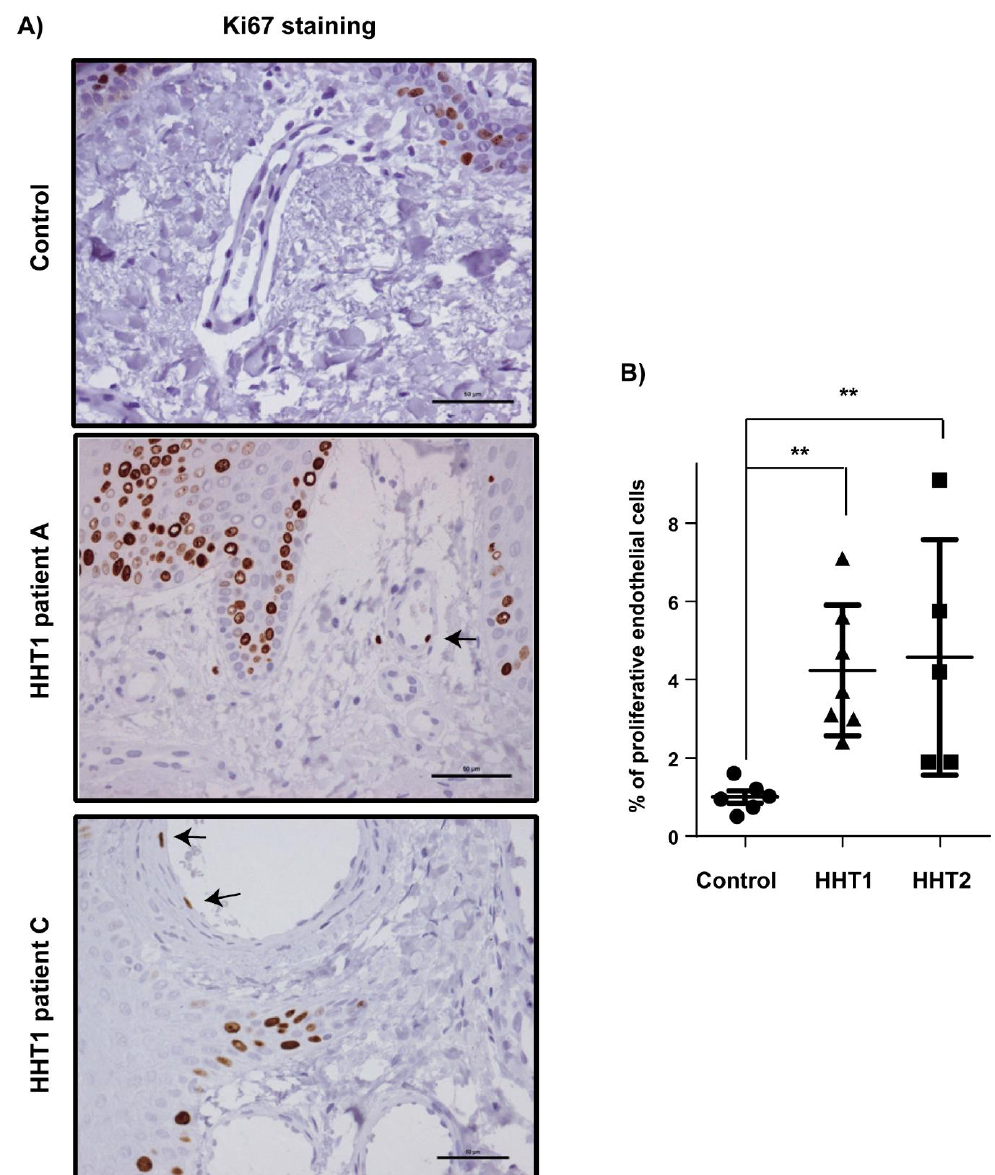
Figure 3. Increased endothelial cell proliferation in HHT1 cutaneous telangiectasia biopsies . ( A ) Ki- 67 (brown nuclei, arrows) staining of endothelial cells in one control and two HHT1 patients. Scale bars, 100 µm. ( B ) Quantification of the percentage of Ki-67-positive endothelial cells in controls (n = 6), HHT1 patients (n = 7), and HHT2 patients (n = 5). Error bars indicate the standard errors of the mean. Statistical significance of two-tailed Mann – Whitney U tests: ** p < 0.01.